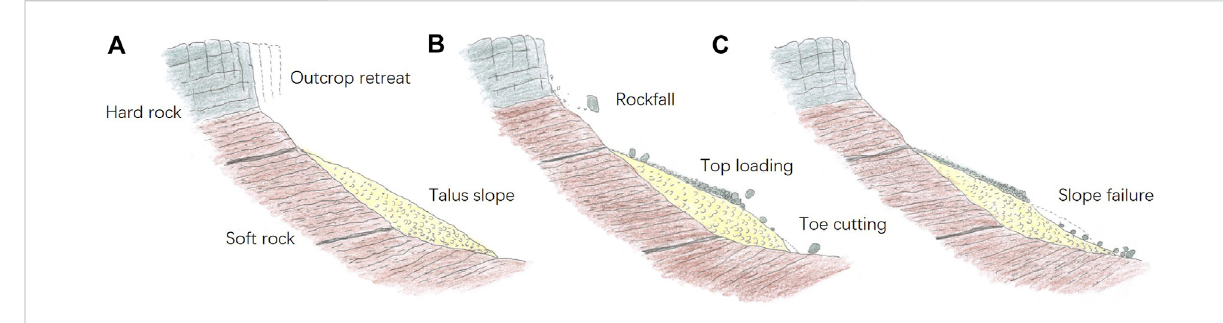
FIGURE 12 Schematic diagram of the formation mechanism and failure mode of a talus slope induced by rockfalls. (A) outcrop retreat, (B) top loading and toe cutting, (C) slope